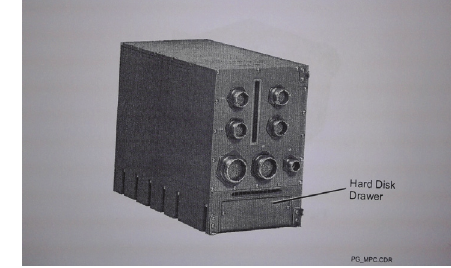
Figure 13 – MPC - Mission Personal Computer Рис . 13 – MPC Персональный компьютер для миссии Слика 13 – MPC – Персонални компјутер за